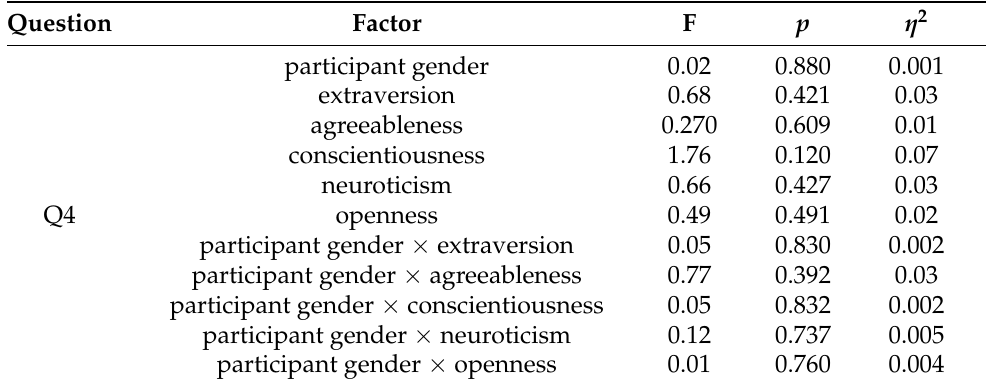
Table A4. GLM analysis of the effect of participants’ personality traits (i.e., extraversion, agreeable- ness, conscientiousness, neuroticism, openness) on their responses to question Q4.